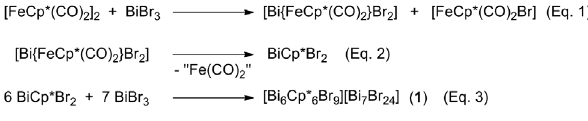
Table 1 Crystallographic data and structure refinement details